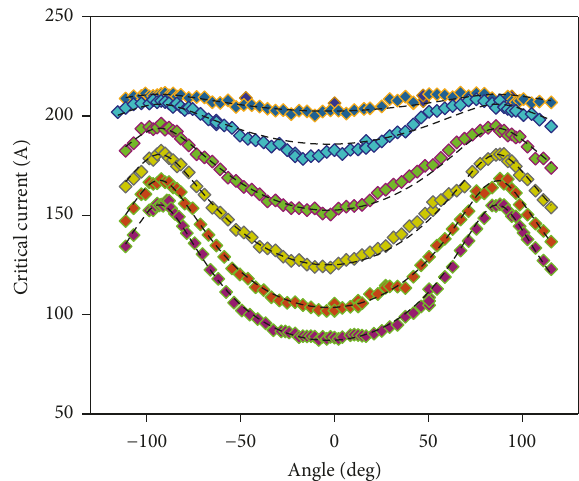
Figure 3: Finite element model mesh for the original configuration